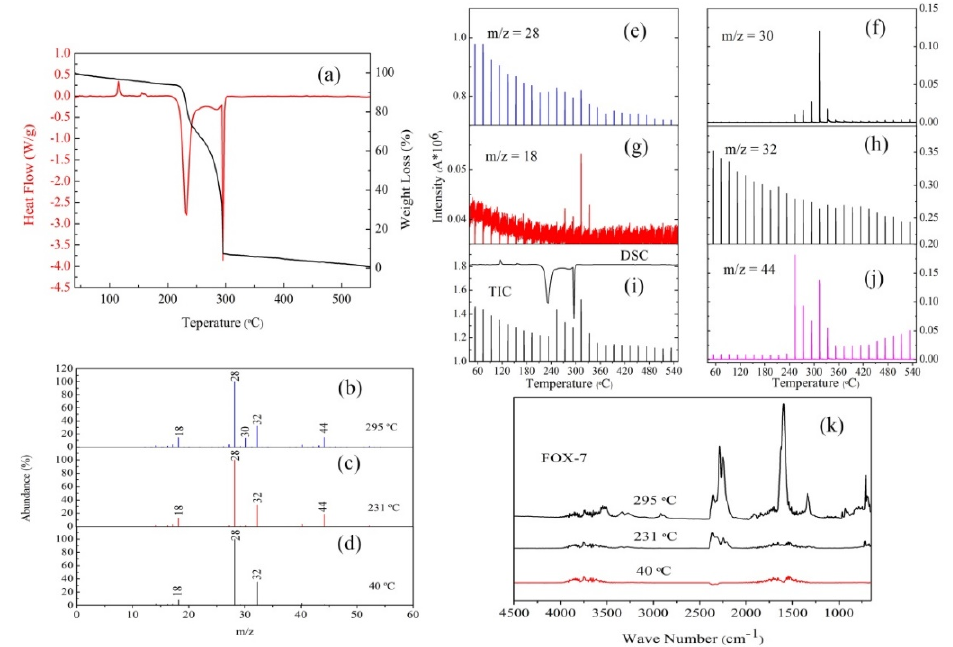
Figure 9. ( a ) DSC and TG curves of FOX-7 with heating rate of 10 ◦ C / min; the MS spectra of FOX-7 at ( b ) 295 ◦ C, ( c ) 231 ◦ C and ( d ) 40 ◦ C; the ion current spectra of FOX-7 in the decomposition with ( e ) m / z = 28, ( f ) m / z = 30, ( g ) m / z = 18, ( h ) m / z = 32, ( i ) total ion current, ( j ) m / z = 44; ( k ) IR spectra of FOX-7 at 295 ◦ C, 231 ◦ C and 40 ◦ C.